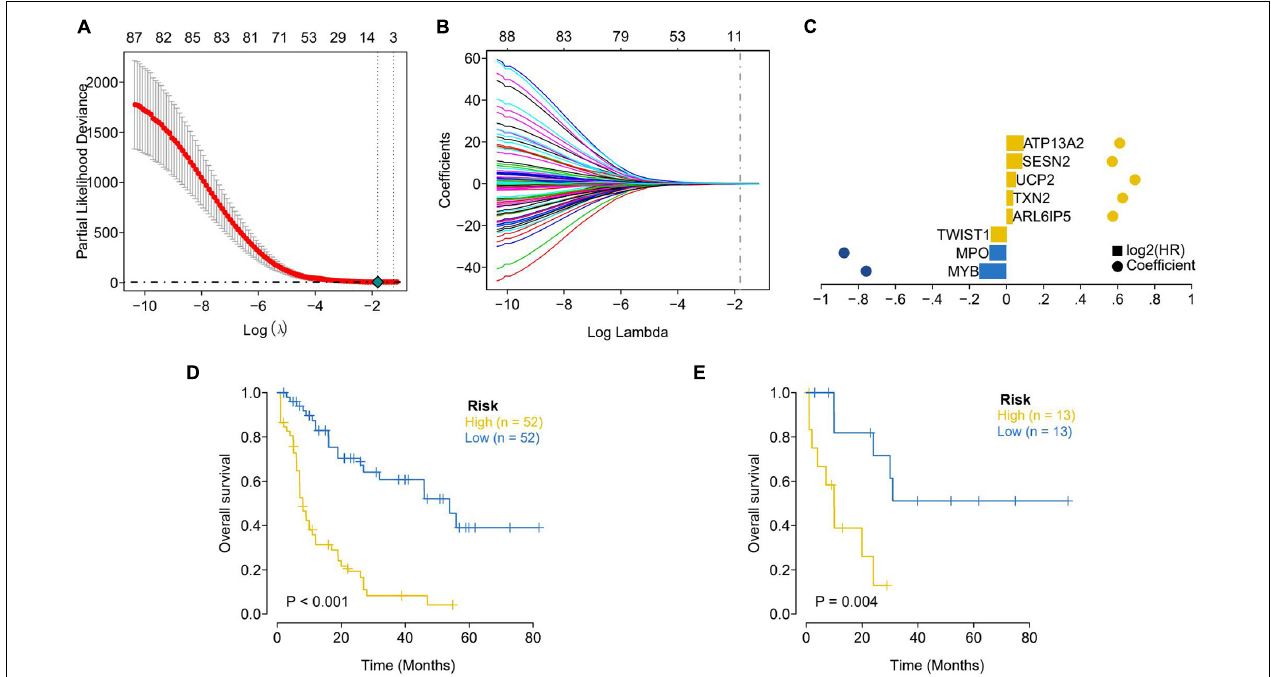
FIGURE 2 | Lasso regression analysis was used to select the optimal coefficients. (A) Screening the best Partial Likelihood Deviance value and the best Lambda value. (B) The optimal coefficient of each gene was obtained through the optimal Lambda. (C) Display of LASSO regression results for each key gene. The distance between the bubbles represents the coefficients; the height of the column represents the size of the log2 (HR) value. (D) Assessment of survival differences between the high-risk (52 samples) and low-risk groups (52 samples) in the training dataset. (E) Internal validation focused on the assessment results of survival differences between the high-risk (13 samples) and low-risk (13 samples) group. The yellow line represents the high-risk group and the blue line represents the low-risk group.